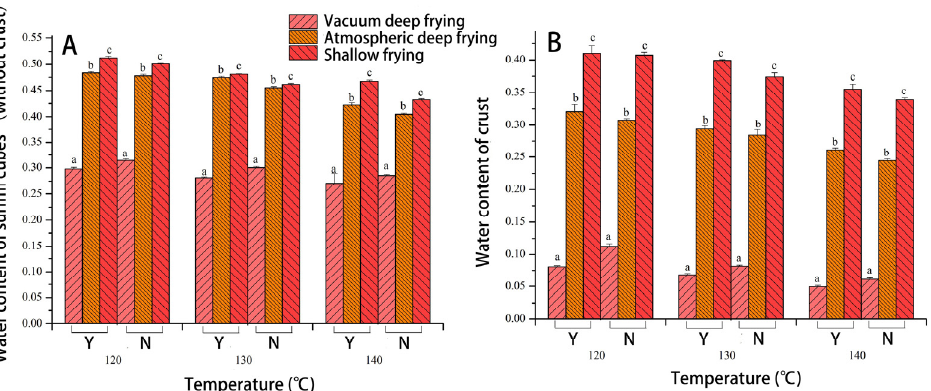
Figure 7. Effect of different frying techniques on water content of surimi cubes (( A ) surimi cubes without crust; ( B ) crust; Y: Raphanus sativus added; N: no Raphanus sativus ). Different letters in the same chart represent significant differences between different treatments according to Duncan’s multiple range test. ( p < 0.05).